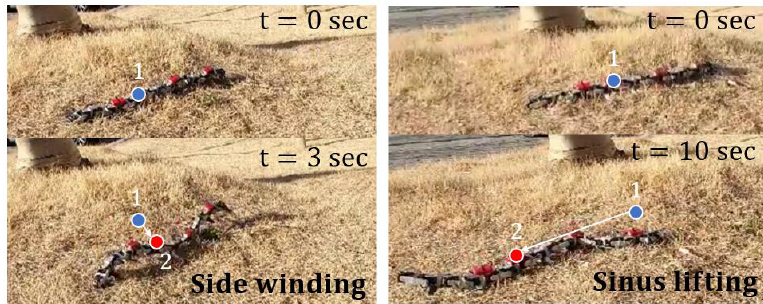
Figure 19. Performance of side winding and sinus lifting motion with the DAM in rough terrain.